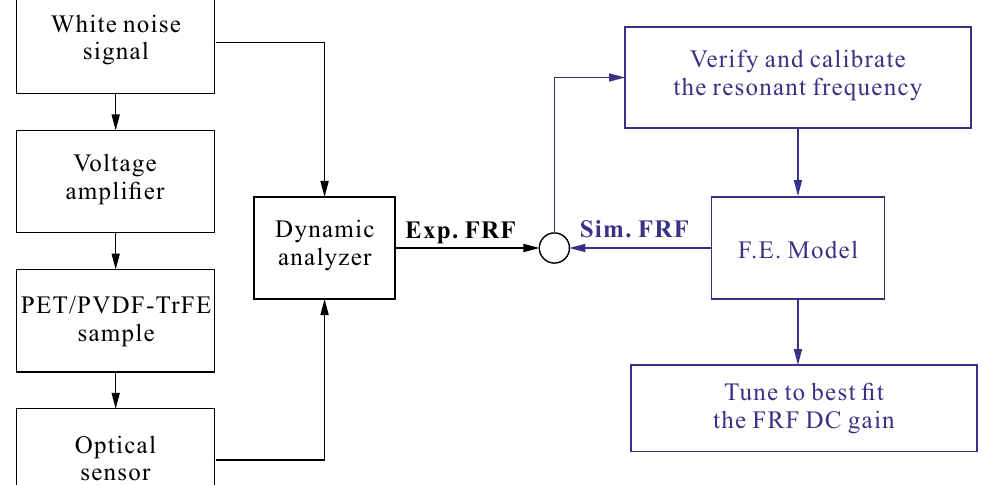
Figure 4. Block diagram of the estimation of d 31 from